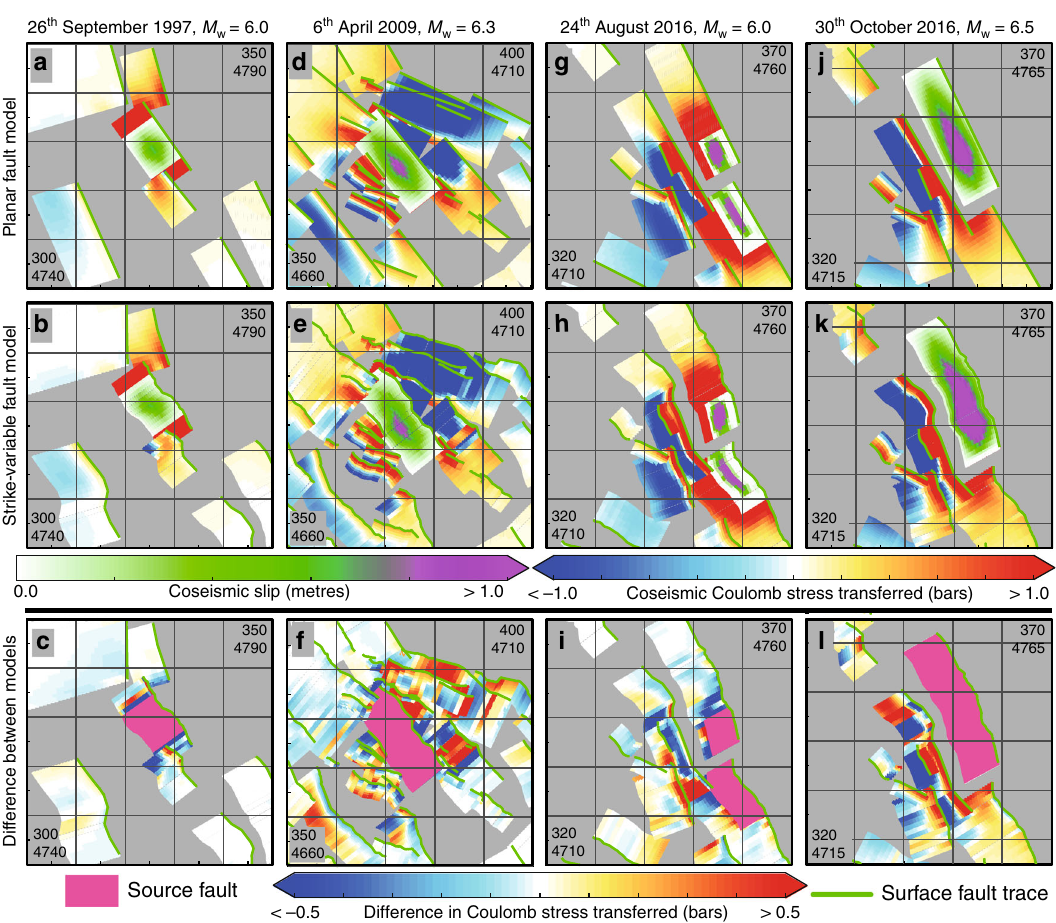
Fig. 2 Comparing planar and strike-variable coseismic stress models. Coulomb stress transfer (CST) for four recent earthquakes; 26 September 1997 (panels a , b , c ); 6 April 2009 (panels d , e , f ); 24 August 2016 (panels g , h , i ); 30 October 2016 (panels j , k , l ). The coseismic CST and slip distributions used are shown in colour scales, UTM coordinates for the north-east and south-west corner of each panel are given (33 T zone). Panels a , d , g , j show the planar fault geometry CST models, panels b , e , h , k show the strike-variable fault geometry CST models, panels c , f , i, l show the difference between the coseismic CST models for the four earthquakes investigated. A positive difference indicates that including the fault geometry has increased the